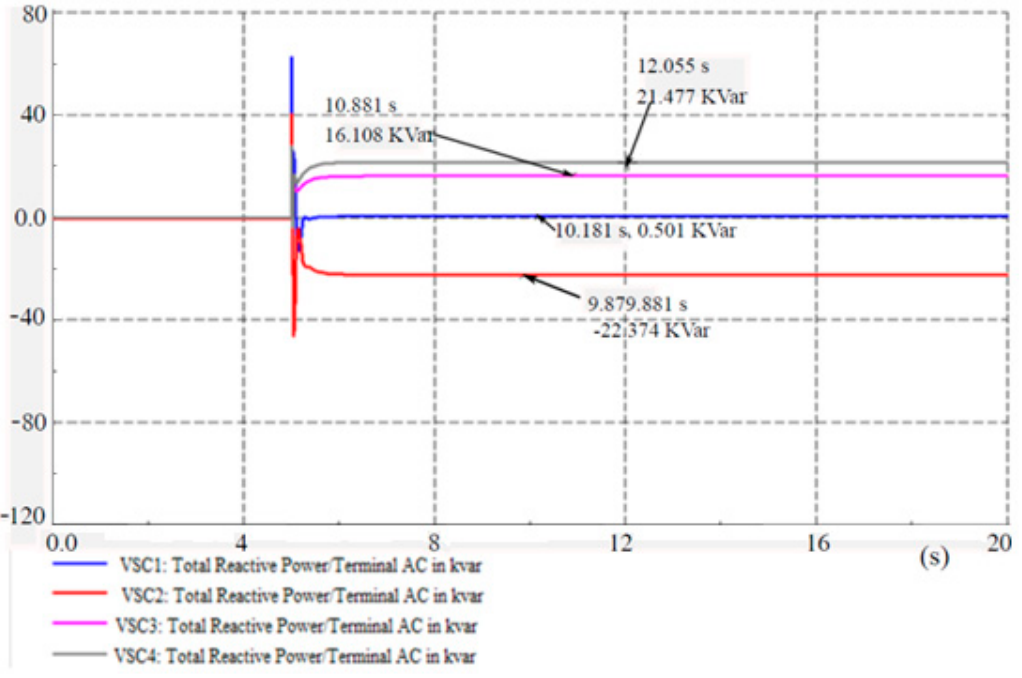
Figure 8. The reactive power of VSC1, VSC2, VSC3, and VSC4 in case of grid connected and islanded mode.